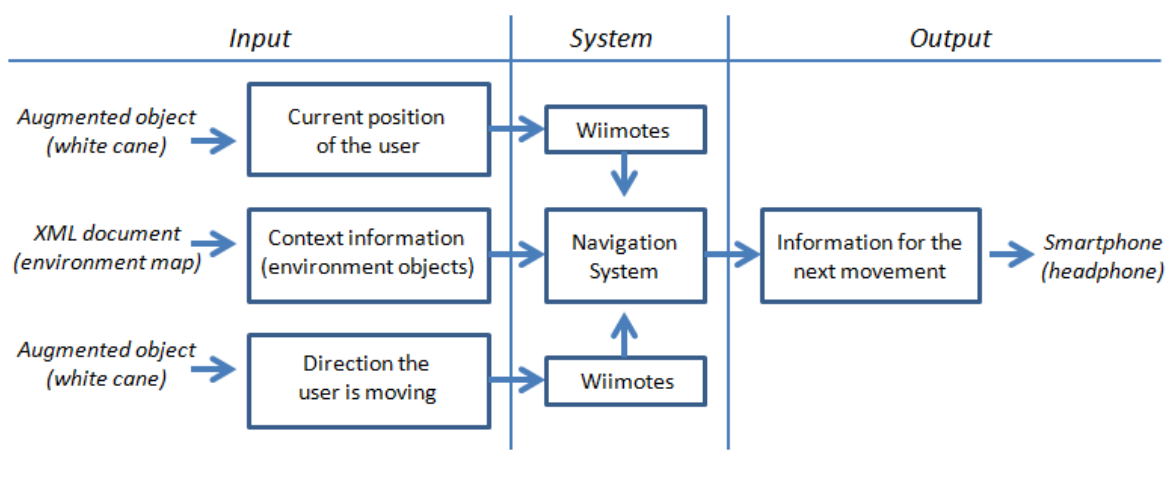
Figure 2. Main structure of the navigation